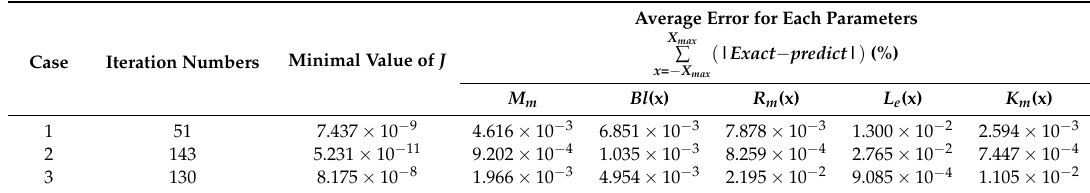
Table 3. Convergence results of linear and nonlinear